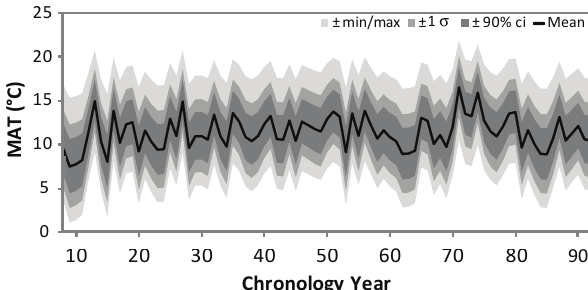
Figure 5. Mean annual temperature (MAT ◦ C) based on all δ 18 O- temperature reconstructions. Mean of all reconstructions (black line) is bracketed by 90% confidence interval ( ± 90% ci, dark gray fill), one standard deviation ( ± 1 σ , medium gray fill), and mini- mum/maximum ( ± min/max, light gray fill)